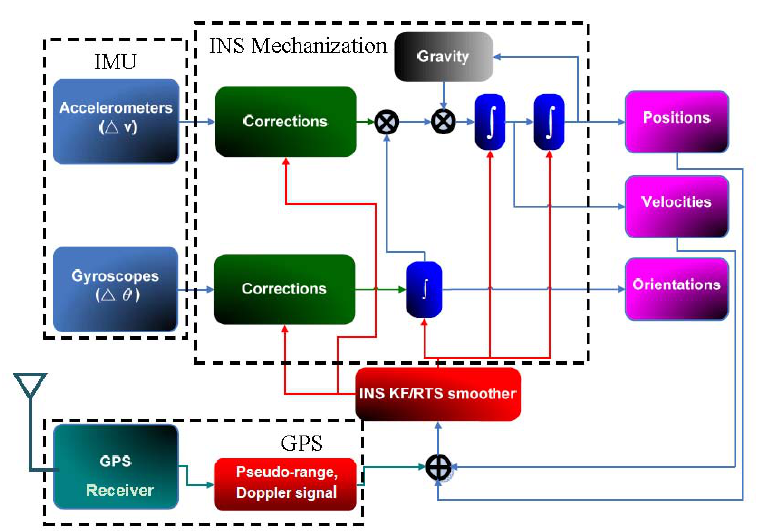
Figure 9. Tightly coupled scheme.